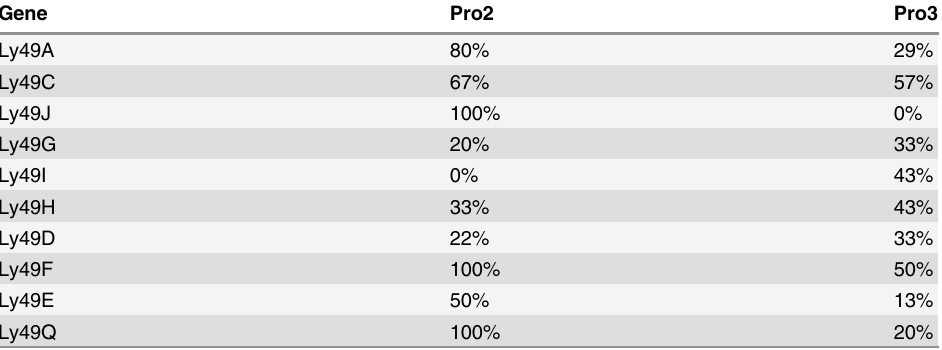
Table 1. Convergence of actual and predicted nucleosomes at the indicated